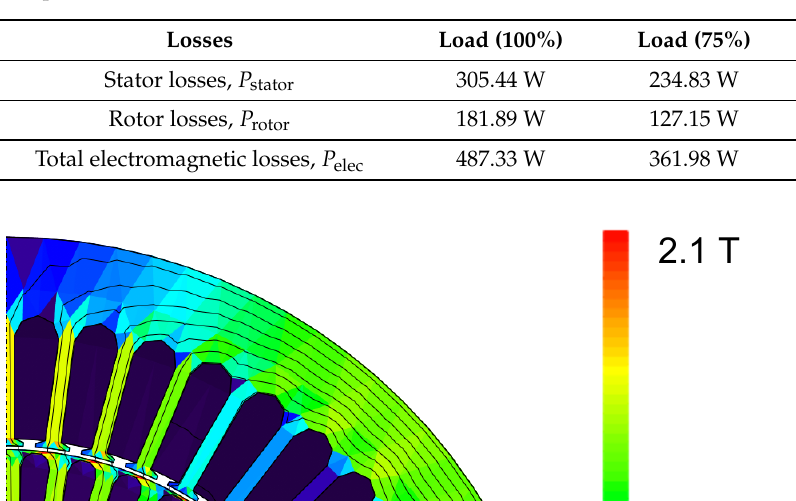
Table 15. Comparison of losses for various load points of the optimal design 3-variable optimiza- tion problem.